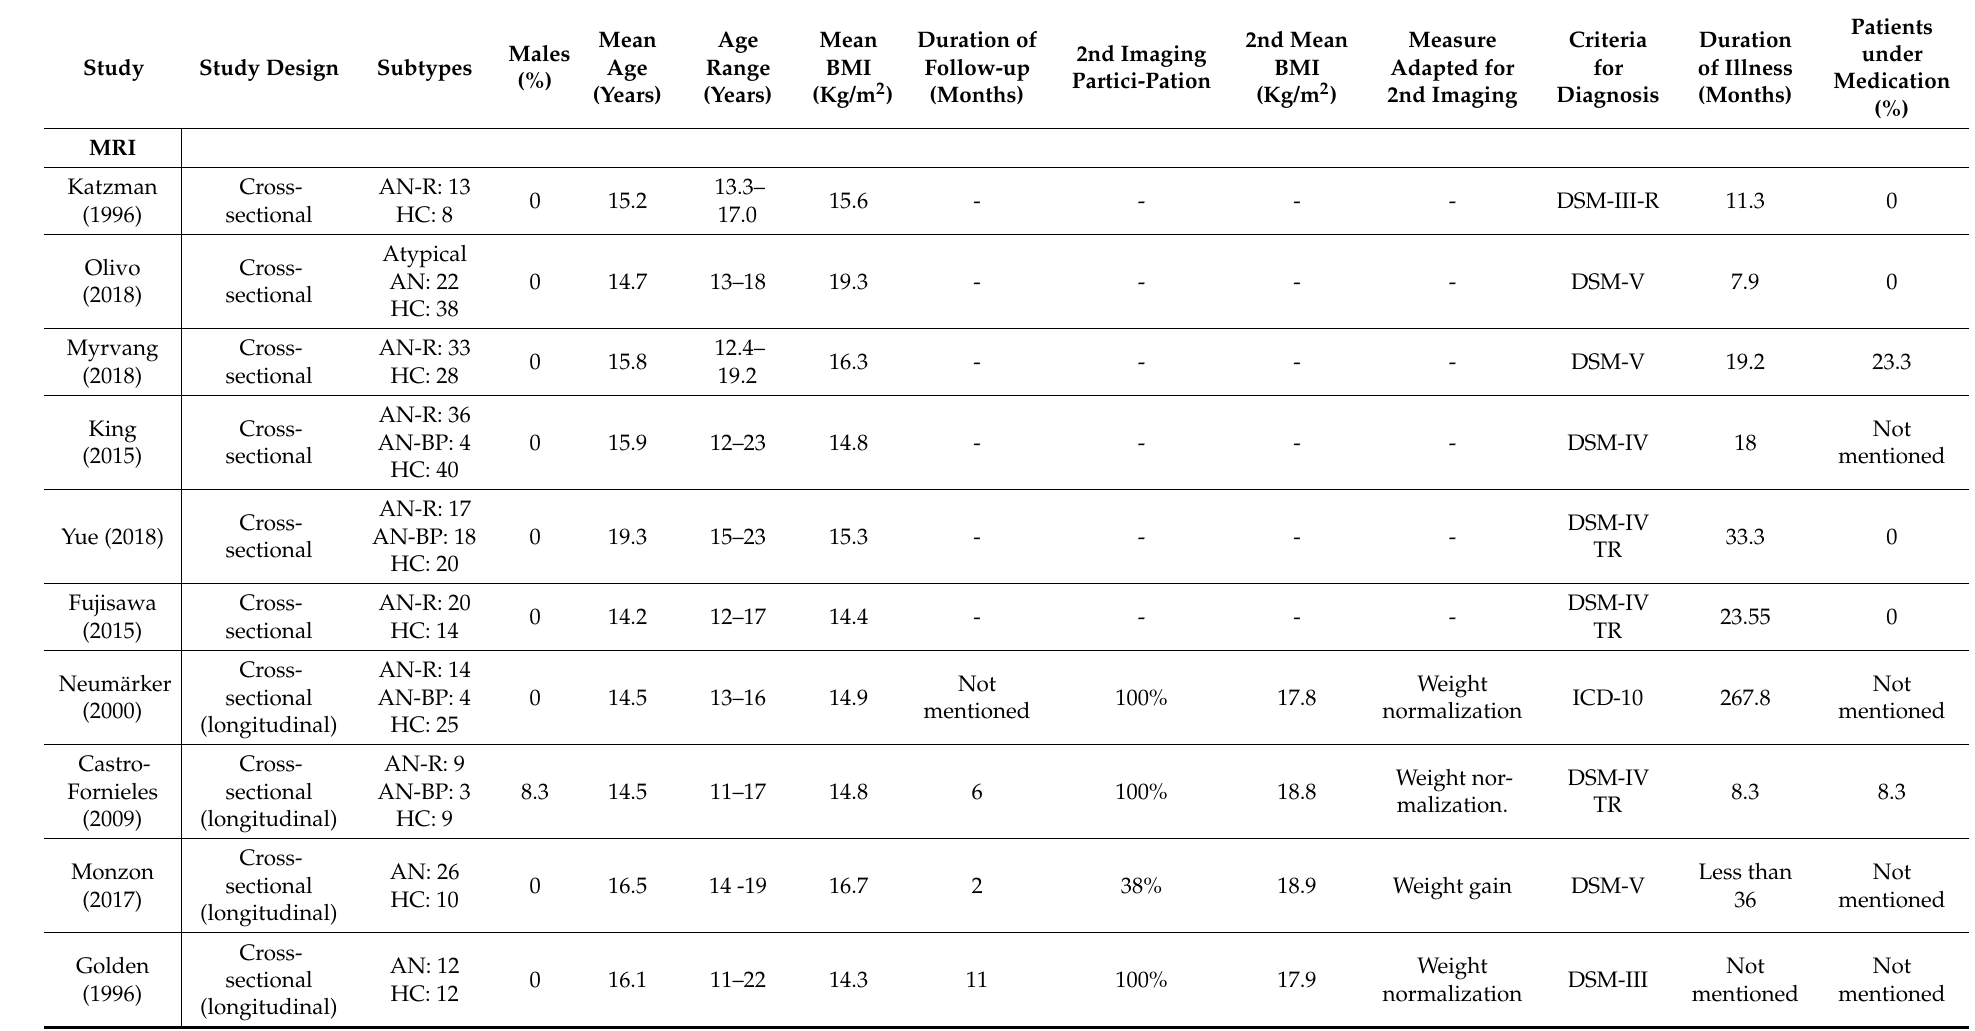
Table 1. Structural imaging studies—sample